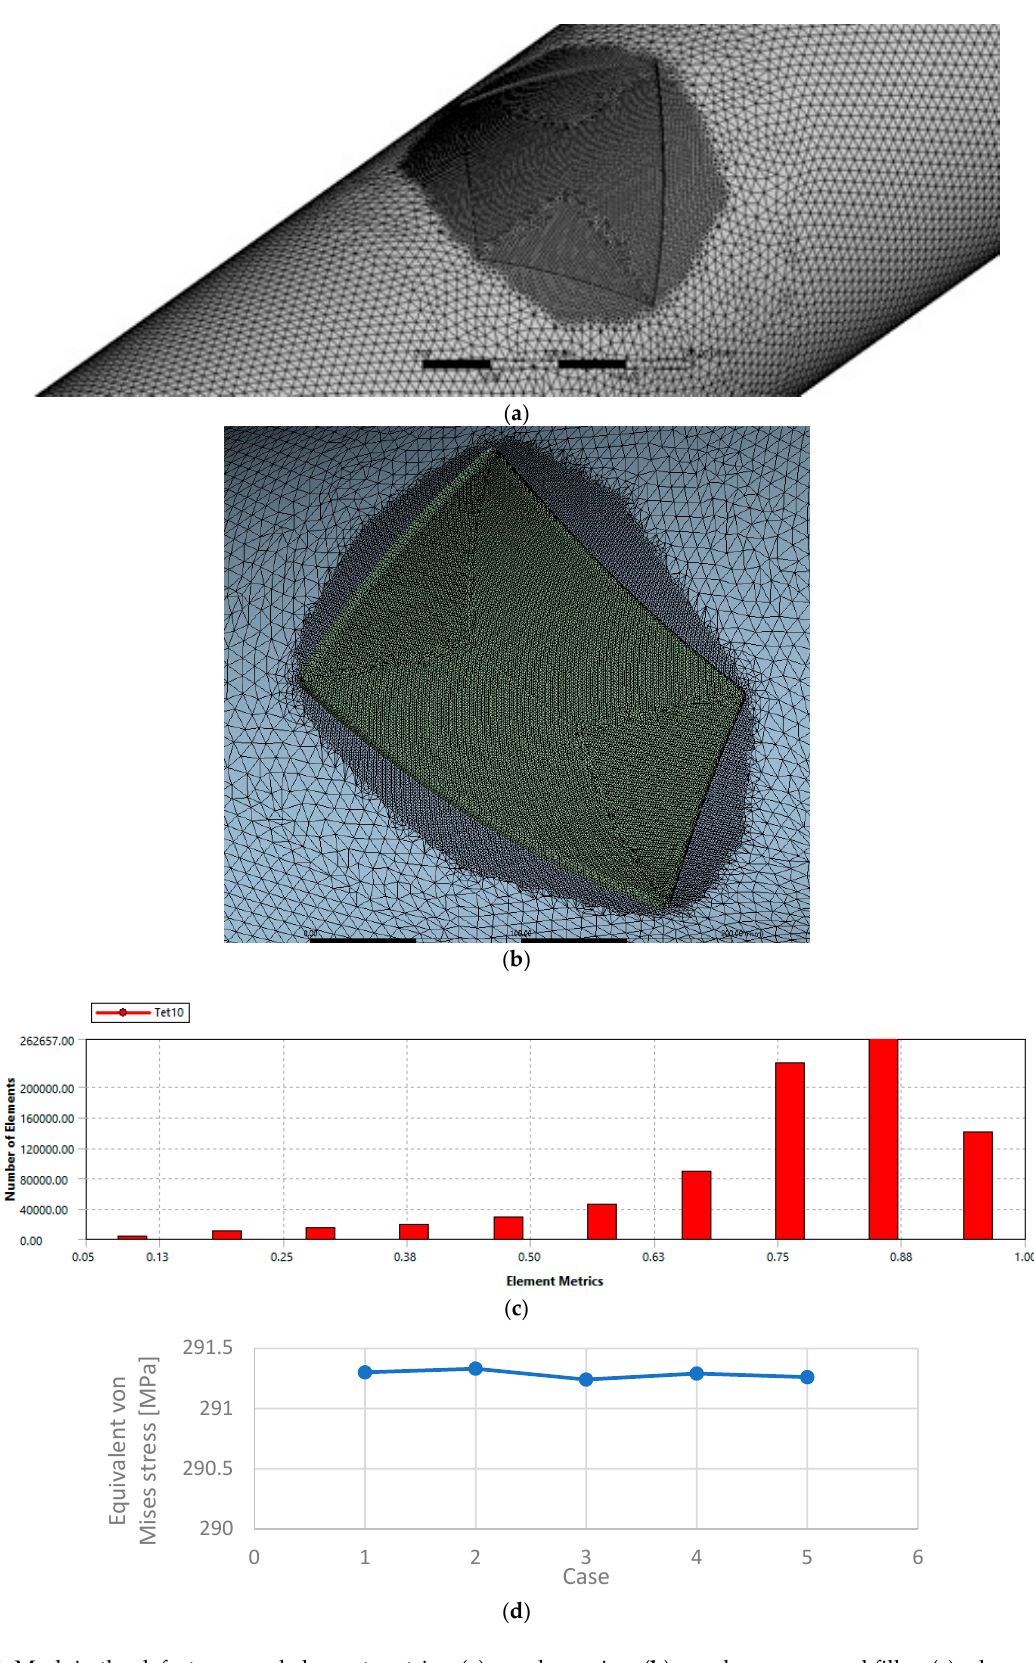
Figure 6. Mesh in the defect area and element metrics: ( a ). mesh on pipe; ( b ). mesh on wrap and filler; ( c ). element quality metric (see also Table 3 below); ( d ). influence of elements dimensions.